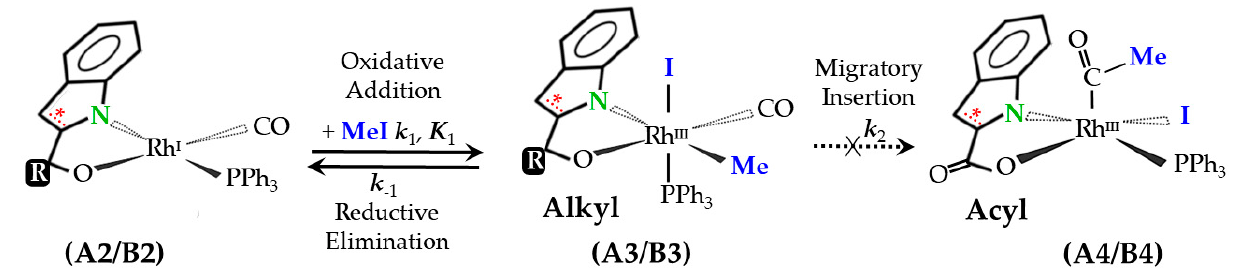
Figure 7. Typical first-order fits ( k obs values given on graph) to Equation (1) of: (A) Absorbance changes as a function of time (see Figure 4): (a) IR: disappearance of B2 ; the Rh 1 (I) fragment; (b) IR: formation of the Rh III -alkyl species in dichloromethane at 25 ◦ C ([ B2 ] = 0.0058 M and [MeI] = 0.064 M); (c) UV/Vis time trace in dichloromethane at 25 ◦ C, λ = 450 nm, [ B2 ] = 8.35 × 10 − 4 M, and [MeI] = 0.088 M (when k obs normalized to [MeI] = 0.064 M, k obs = 5.00(3) × 10 − 3 s − 1 ). (B) 31 P{ 1 H} NMR Integrals as a function of time (see Figure 5) for the (d) disappearance of the Rh 1 (I) species and (e) formation of the Rh III -alkyl species and of B5 ([ B2 ] = 0.0058 M; in dichloromethane at 25 ◦ C; [MeI] = 0.064